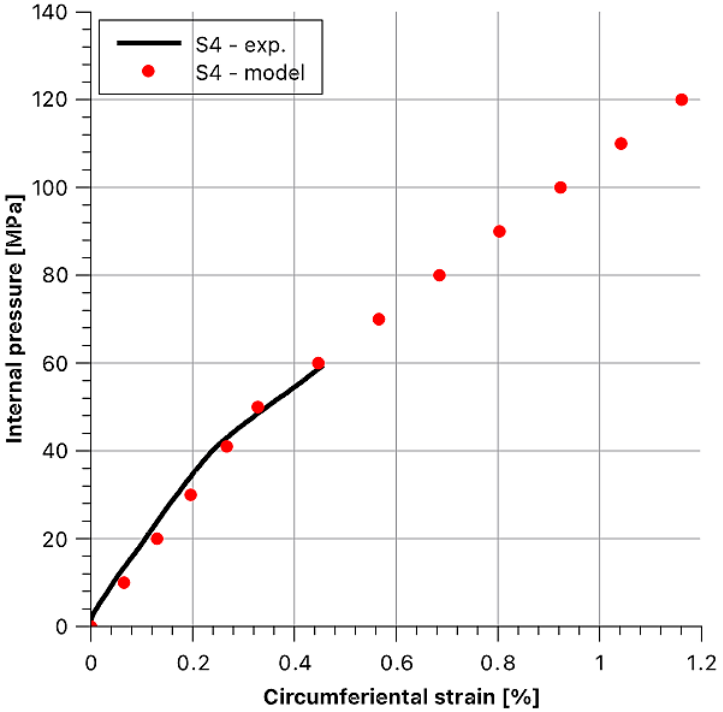
Figure 23. Stress and strain results as a function of internal pressure for sample S4.